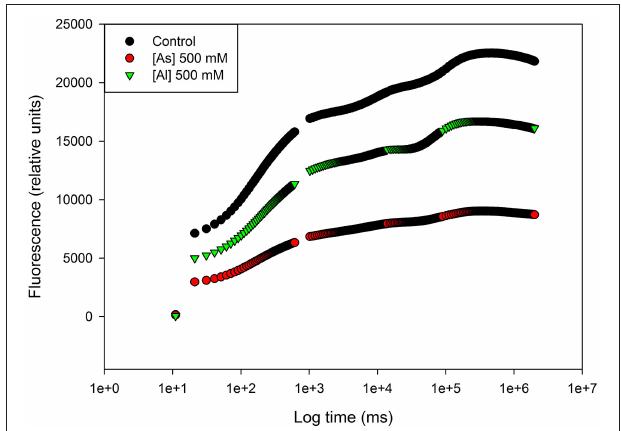
FIGURE 3 | Kautsky curves in dark adapted leaves of Tamarix gallica exposed to arsenic (As) and aluminum (Al; average). The concept of this figure is based on Sghaier et al.